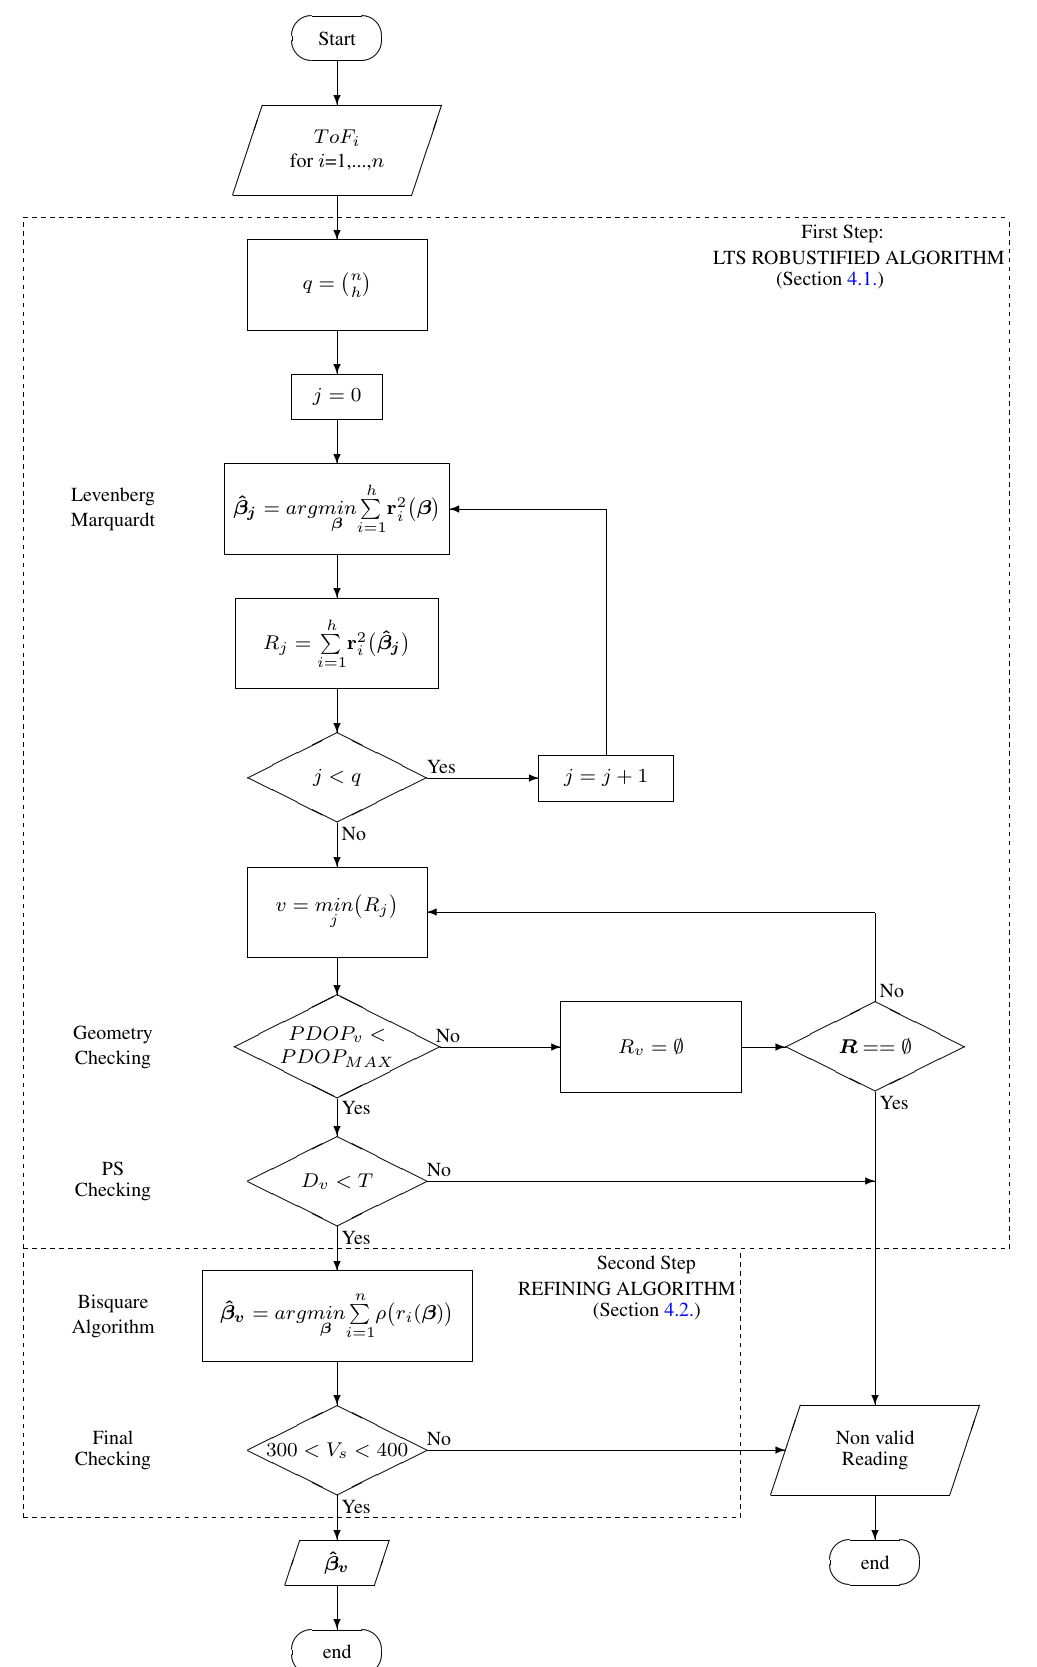
Figure 1. Flowchart of the RoPEUS